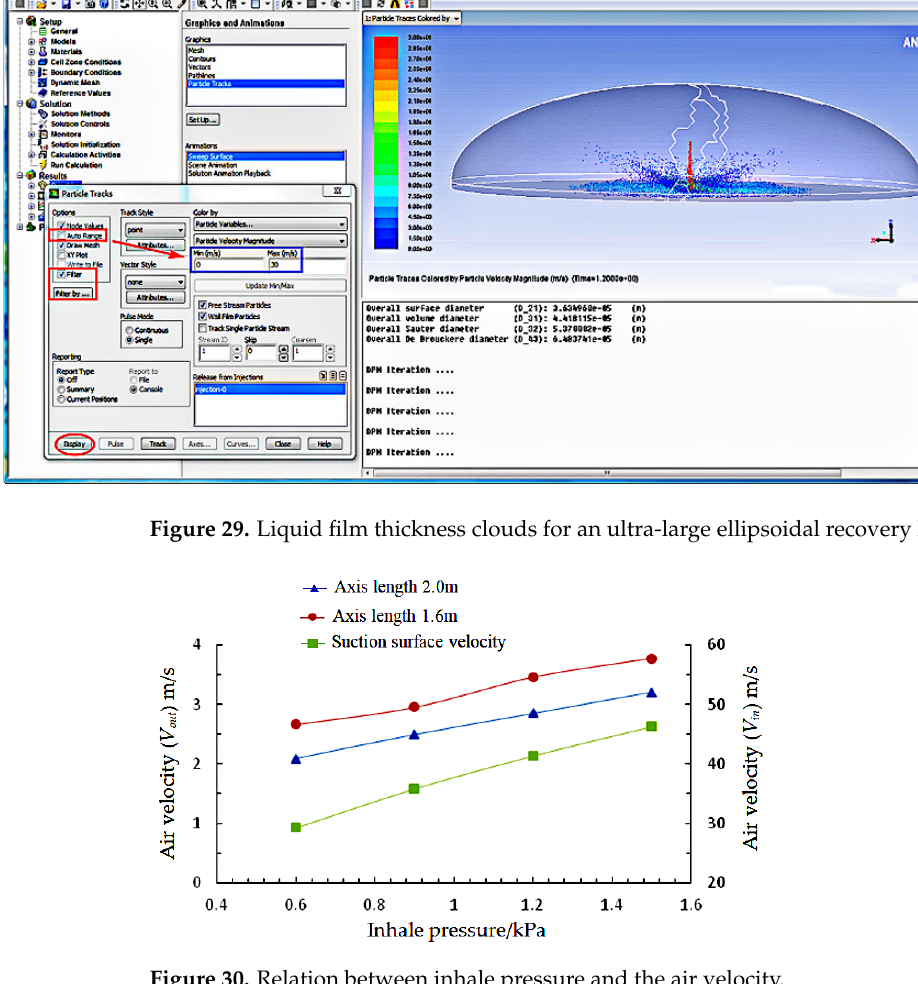
Figure 30. Relation between inhale pressure and the air velocity. Table 6. Percentages of the escaping mist in the improved